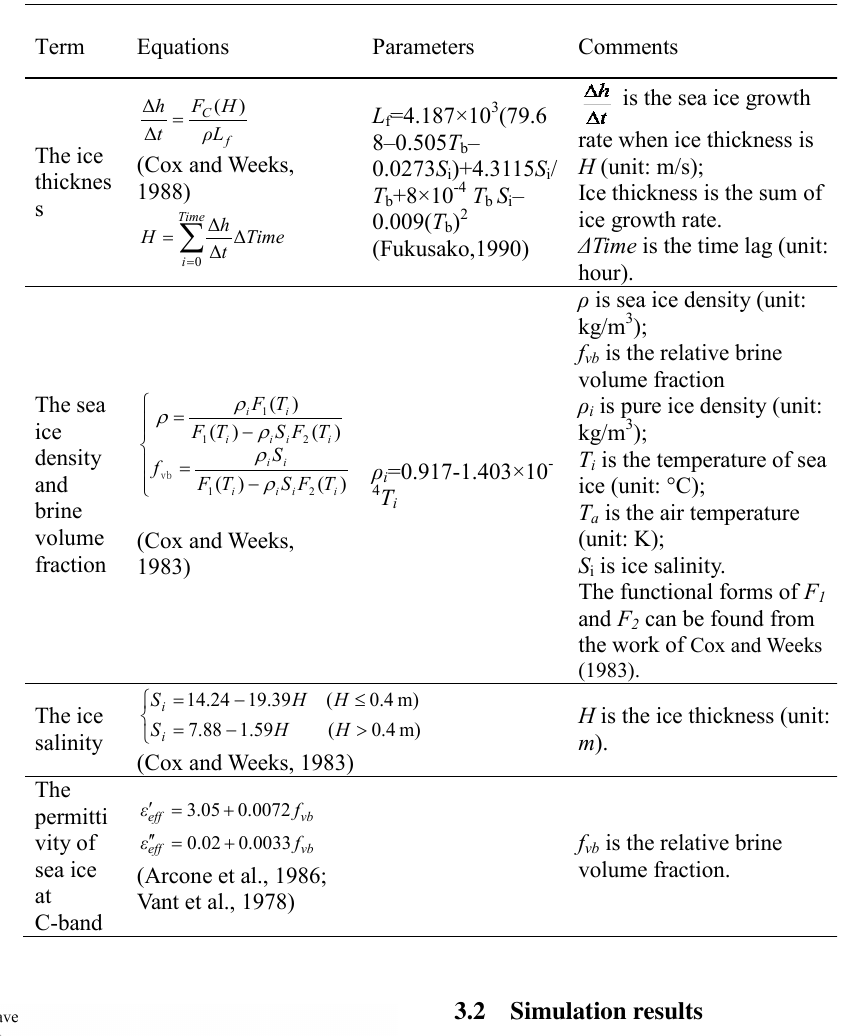
Table 2. Equations and parameters used for the sea ice properties.